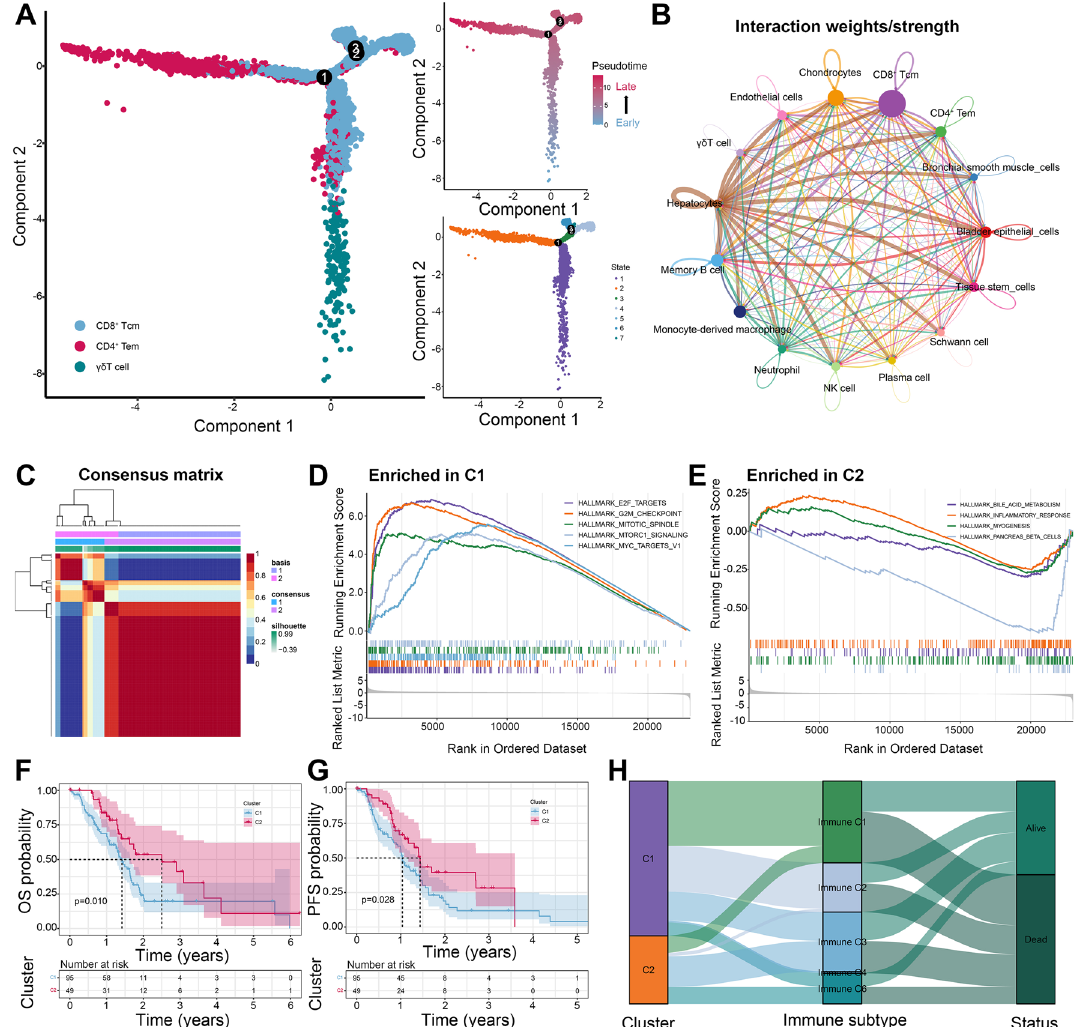
Figure 3. Cell trajectory and pseudo-time analysis of T cells subtypes and identification of two molecular subtypes based on TMGs expression pattern. ( A ) Cell trajectory and pseudo-time analysis of three T cells subtypes. The left panel is the cell trajectory of CD8 + Tcm (blue color), CD4 + Tem (red color), and γδT cell (green color); The right top panel is the pseudo-time analysis of three subtypes of T cells. The blue color represents the early state of T cells, and the red color represents the late state of T cells; The right bottom panel is the cell fate of three subtypes of T cells. ( B ) Cell–cell communication network between different cell types. The size of the circle and the width of the line represent the interaction weight and strength between them. ( C ) NMF identifies two molecular subtypes in PDAC based on the mRNA expression level of TMGs. ( D-E ) GSEA analysis using gene sets from Hallmark indicated that the C1 subtype was significantly enriched in the E2F target pathway, G2M checkpoint pathway, MTROC1 pathway, and MYC pathways ( D ); C2 subtype was associated with bile acid metabolism, inflammatory response, myogenesis, and pancreas beta cells ( E ). ( F-G ) the OS ( F ) and PFS ( G ) between different molecular subtypes. ( H ) Sankey plot displays the relationship between molecular subtypes, immune subtypes, and survival status. TMGs, T cell marker genes; Tcm, central memory T cell; Tem, effector memory T cell; NMF, non-negative Matrix Factorization; PDAC, pancreatic ductal adenocarcinoma; GSEA, gene set enrichment analysis; OS, overall survival, PFS, progression-free